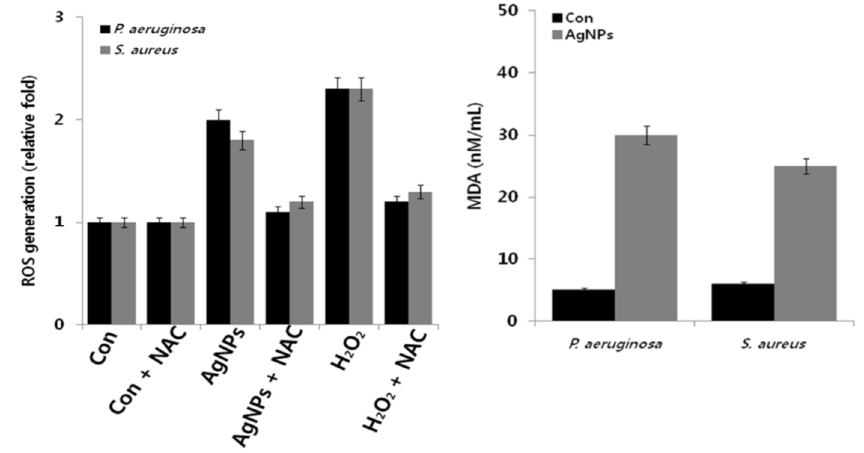
Figure 12. Effects of AgNPs on ROS (left panel) and MDA (right panel) levels. Results were expressed as means ± SD of n = 3; p < 0.05 was considered statistically significant as compared to control (con) groups. Reproduced from [107], MDPI under the Creative Commons Attribution License.